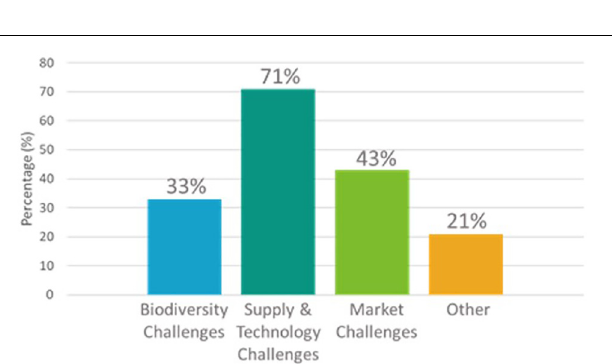
FIGURE 5 | Hurdles identified as a result of the survey can be grouped into four main categories, namely challenges linked to biodiversity (experienced by 33% of survey participants), supply and technology (71%), market (43%), or ’other’ (21%), such as those associated with approval, research funding and